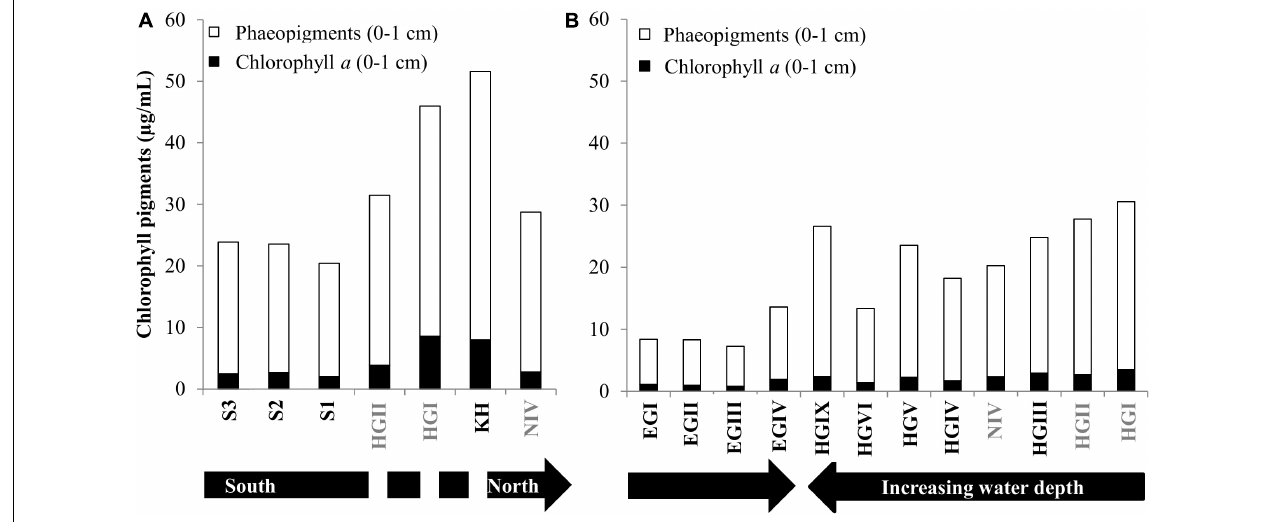
FIGURE 2 | Pigment concentrations. Phaeopigments and Chlorophyll content for surface sediments in 2013 and 2014 ( A,B , respectively). The discontinuity in the black arrow in panel (A) , indicates that HGII, HGI, KH are at a similar latitude. Stations written in gray font were sampled in both years.